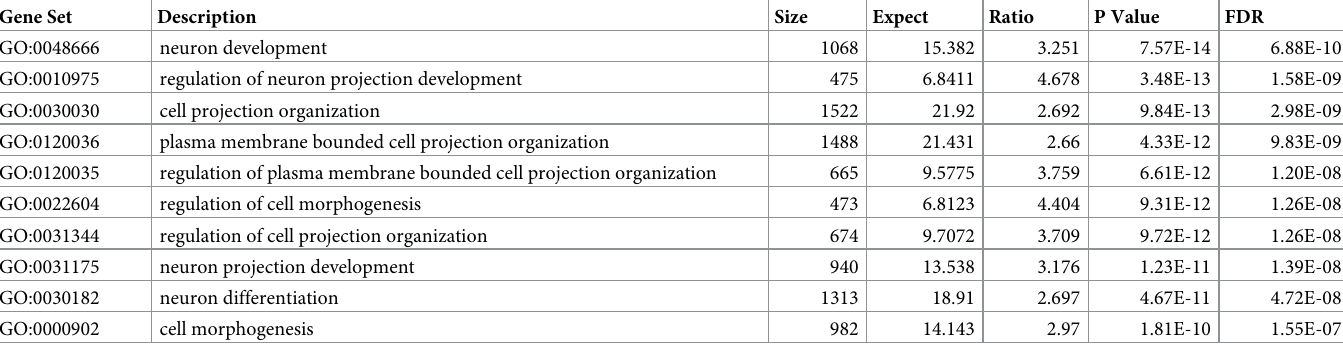
Table 1. GO terms enrichment of genes over-expressed at 26˚C.